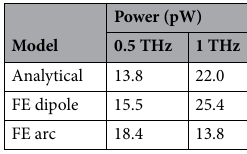
Table 1. Output power of the graphene nanocyclotrons estimated using 3 different